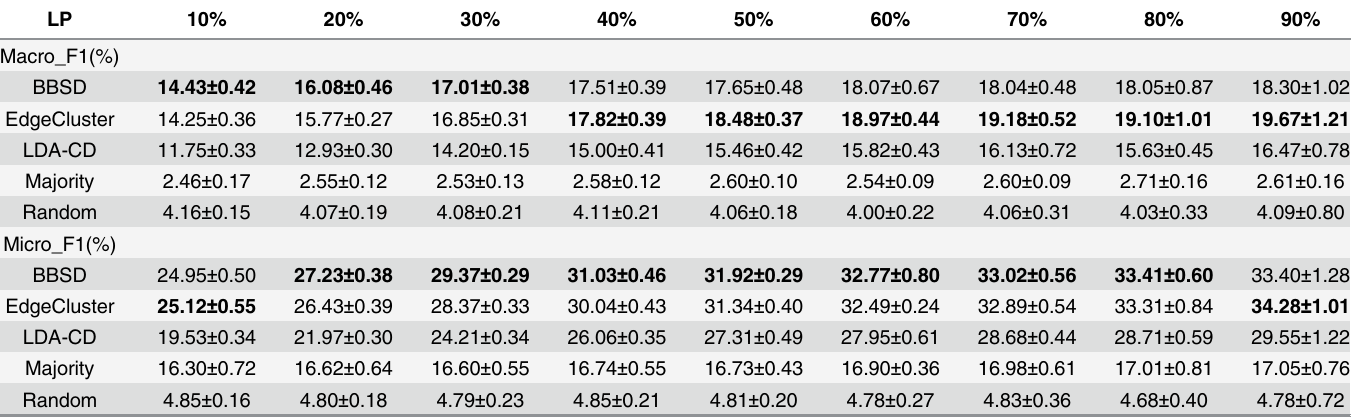
Table 1. Classification performance on Blogcatalog .